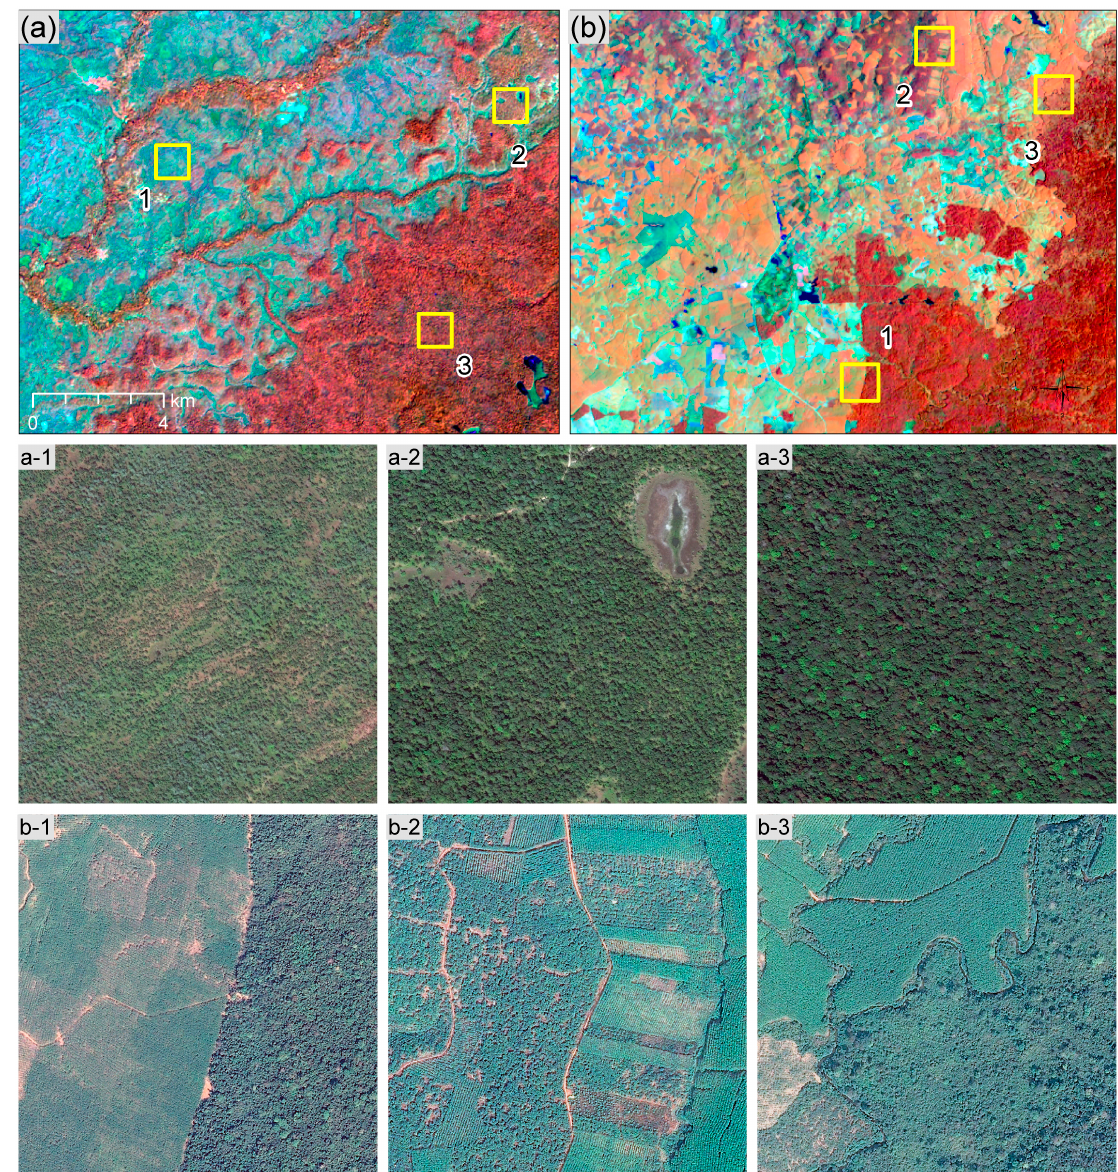
Figure B1. Land cover identification using Landsat and high resolution imagery from Google Earth. Each of the three yellow squares (1-km 2 ) in each Landsat image ( a , b ) are represented by numbered high resolution image chips in panels below. ( a ) Natural forest types are illustrated using a Landsat 7 image from November 2001 (RGB = bands 4, 5, and 2): dry-deciduous forest ( a - 1 ); mixed-deciduous forest ( a - 2 ); and evergreen forest ( a - 3 ). ( b ) Different forest types and plantations are illustrated using a Landsat 8 image from March 2014 (RGB = bands 5, 6, and 3): rubber/evergreen forest frontier ( b - 1 ); other woody plantations with interspersed rubber ( b - 2 ); and rubber and forest regrowth ( b - 3 ).